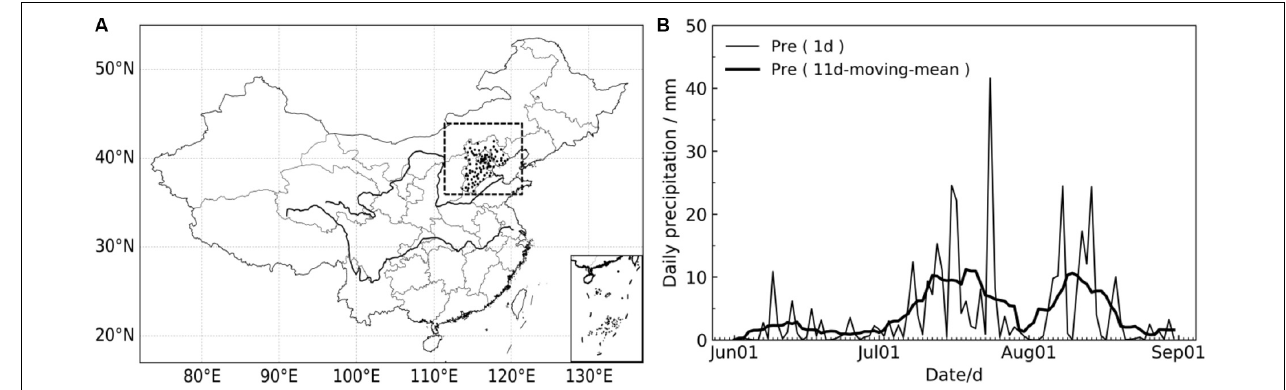
FIGURE 1 | Spatial distribution of precipitation stations (A) and daily precipitation variation (B) in North China in the summer of